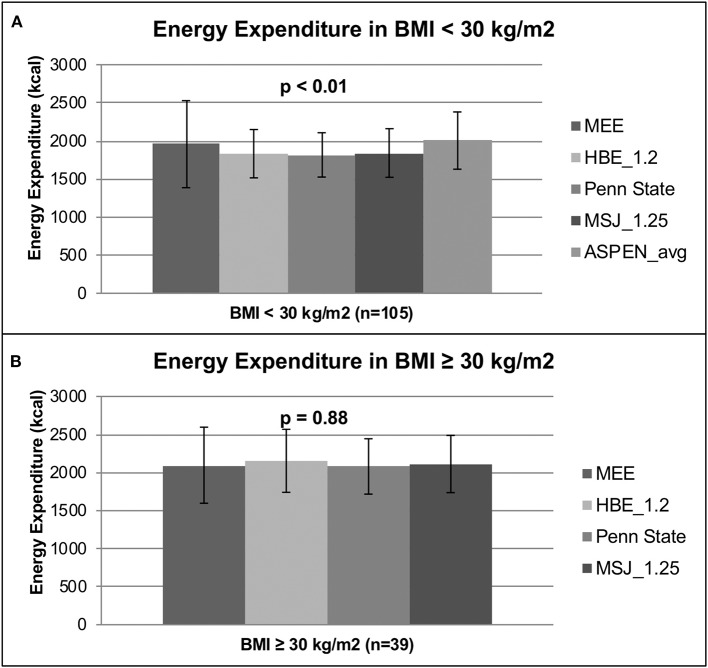
Energy expenditure based on BMI. (A) Energy expenditure based on BMI < 30 kg/m2. (B) Energy expenditure based on BMI ≥ 30 kg/m2.